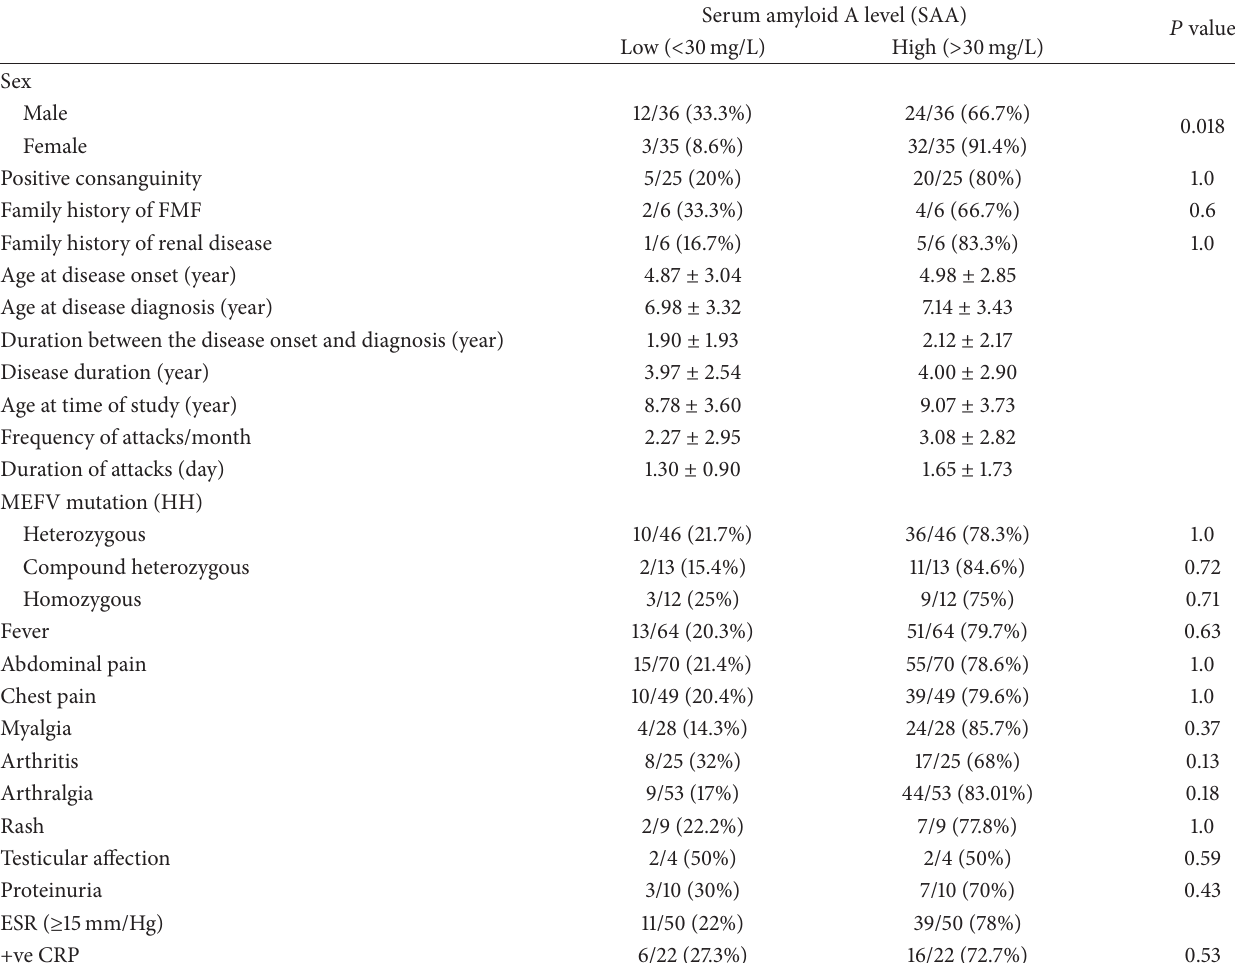
Table 3: Demographic and clinical characteristics of studied patients stratified according to the level of SAA.